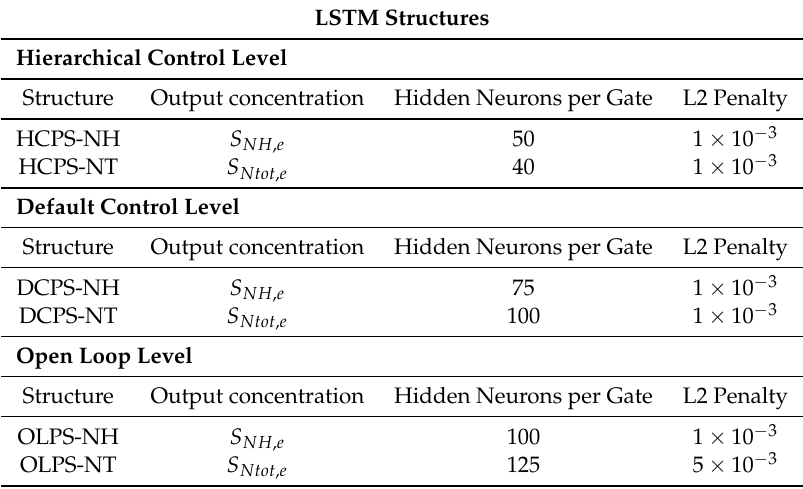
Table 4. Obtained prediction structures (PS). Information related to the number of hidden neurons, L2 penalty, and level of control can be